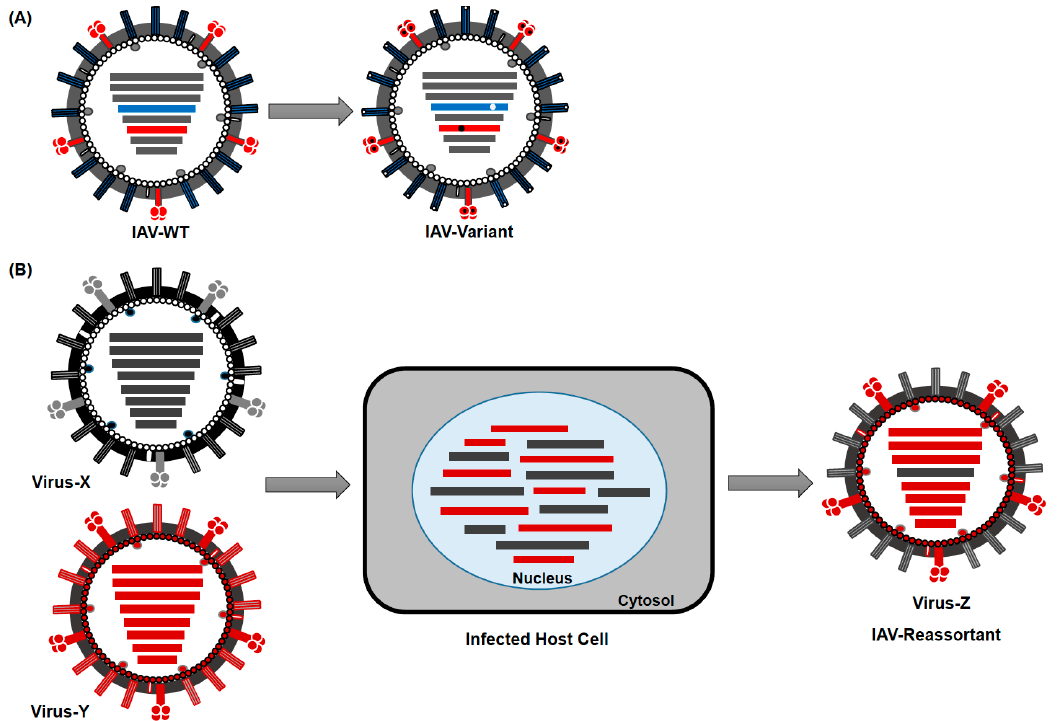
Figure 3. Evolution mechanisms of IAV. ( A ) Antigenic Drift: Gradual accumulation of mutations in the genome of IAVs leads to emergence of new virus variants. Mutations in the HA (blue) and NA (red) can affect the antigenic epitopes leading to antigenically new variants. ( B ) Antigenic Shift: The exchange/reassortment of genetic segments between two or more invading IAVs in a host cell can lead to emergence of (antigenically) distinct new subtype(s).